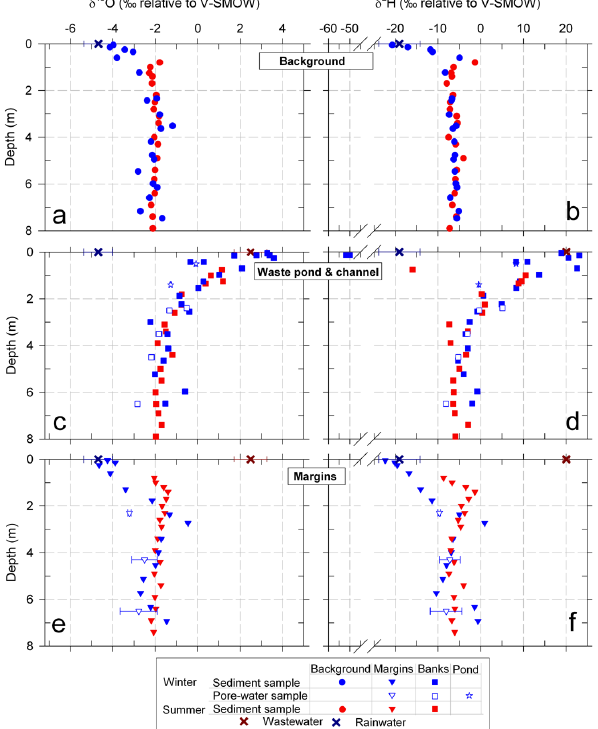
Fig. 4. δ 18 O and δ 2 H in rainwater, wastewater, pore water and in undisturbed sediment samples from the vadose zone underlying the undisturbed background site ( a , b ), permanently flooded waste pond and channel ( c , d ) and waste source margins ( e , f ). The top sample represents an average value for the 0–1.2m depth, section. Values for the depths of 0–0.3m were obtained only at the end of the winter, from sediment samples taken by a garden hand